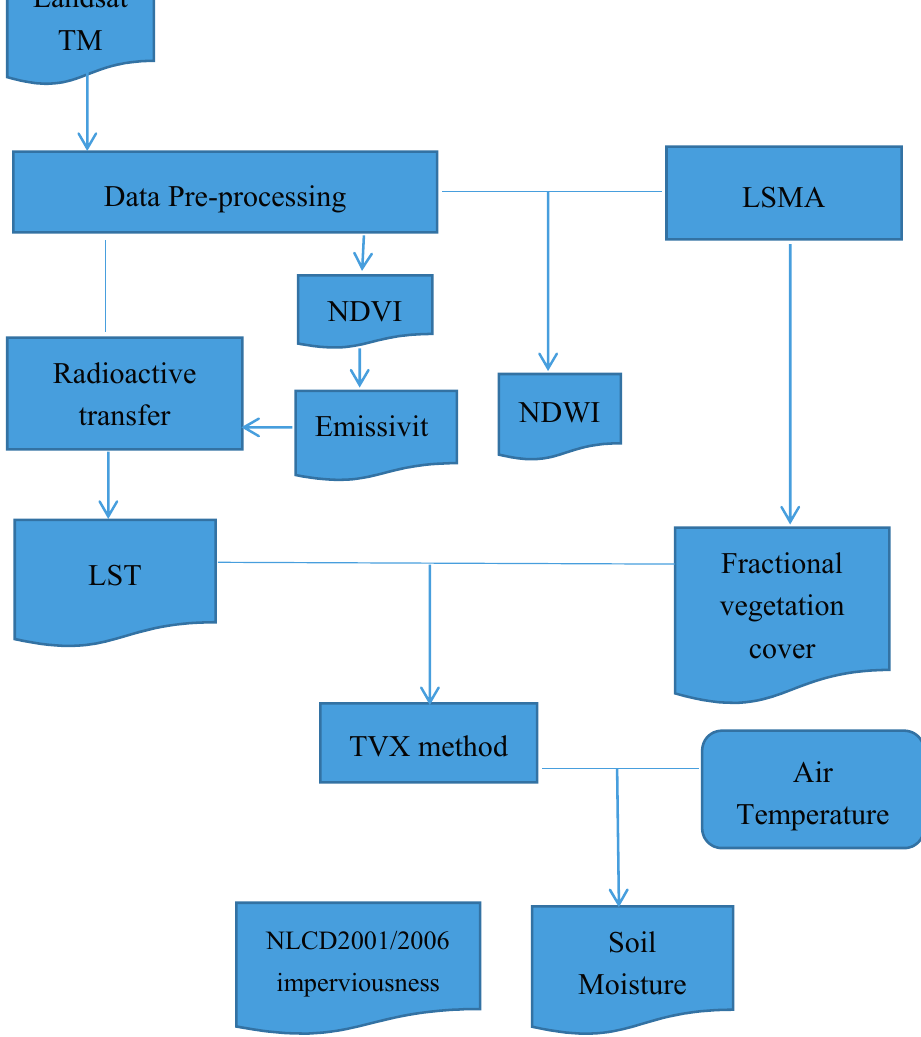
Figure 2. The flowchart of the study. The blue polygons with white text are the resultant biophysical parameters that were compared between 2001 and